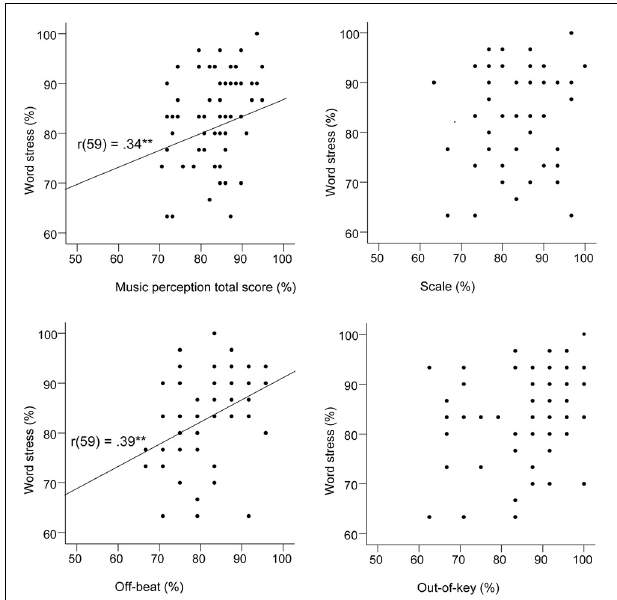
FIGURE 6 | Scatter plots indicating the relationships between the word stress task and the music perception